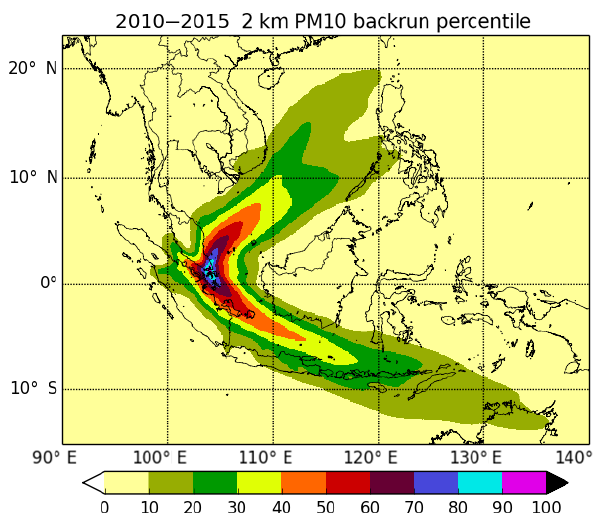
Figure 2. Air history map for 2010–2015, showing where air arriv- ing in Singapore during this period originated from. Each shading shows the relative contribution of air to the central receptor site in Singapore in percent integrated over the atmospheric column from 0 to